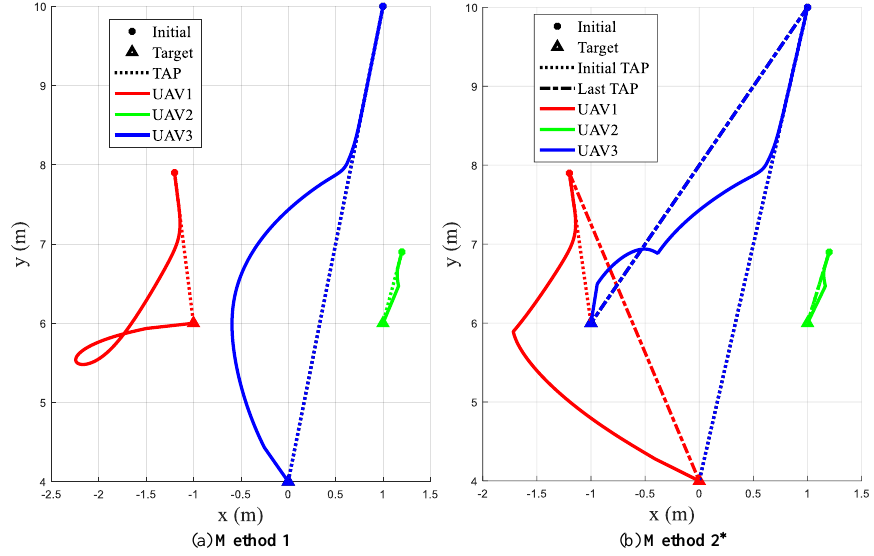
Figure 11. Trajectories of three UAVs planned by Method 1 and Method